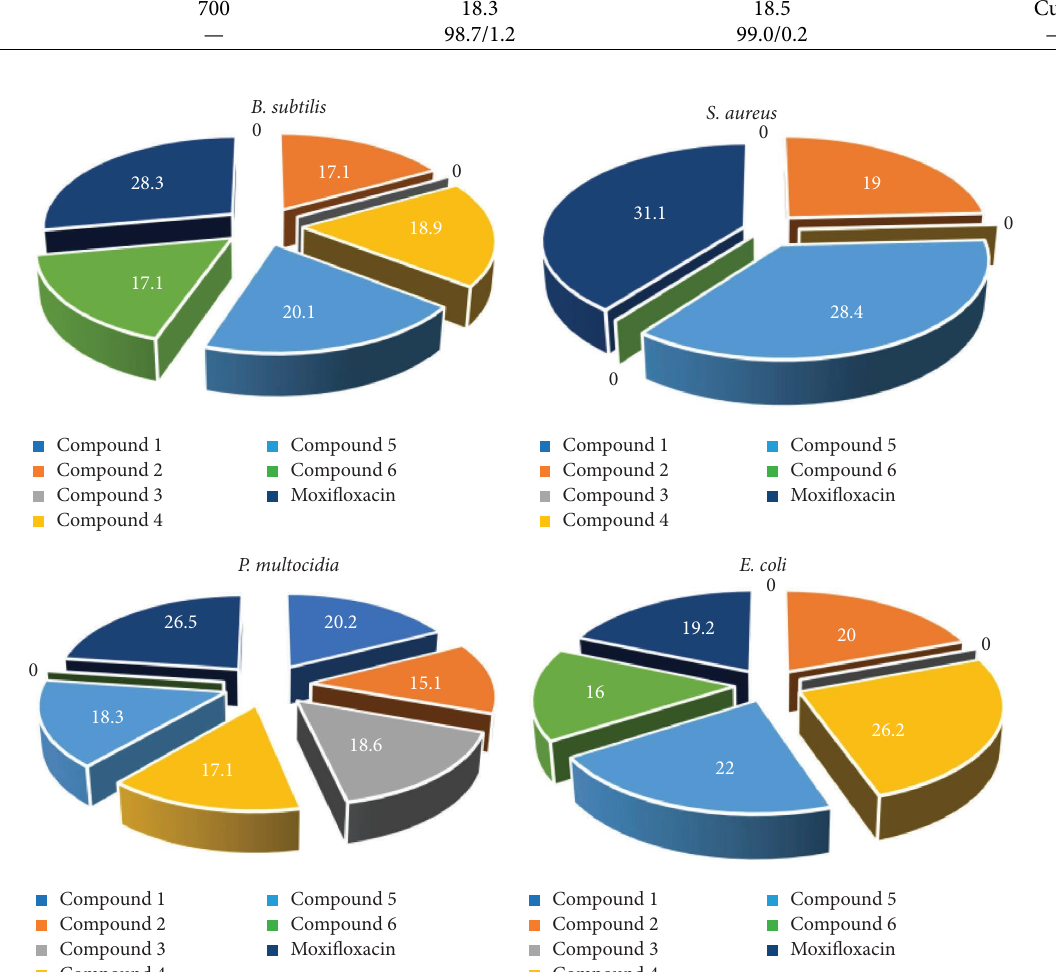
Figure 5: Pie charts representing the extent of antibacterial activities of moxifoxacin and its metal